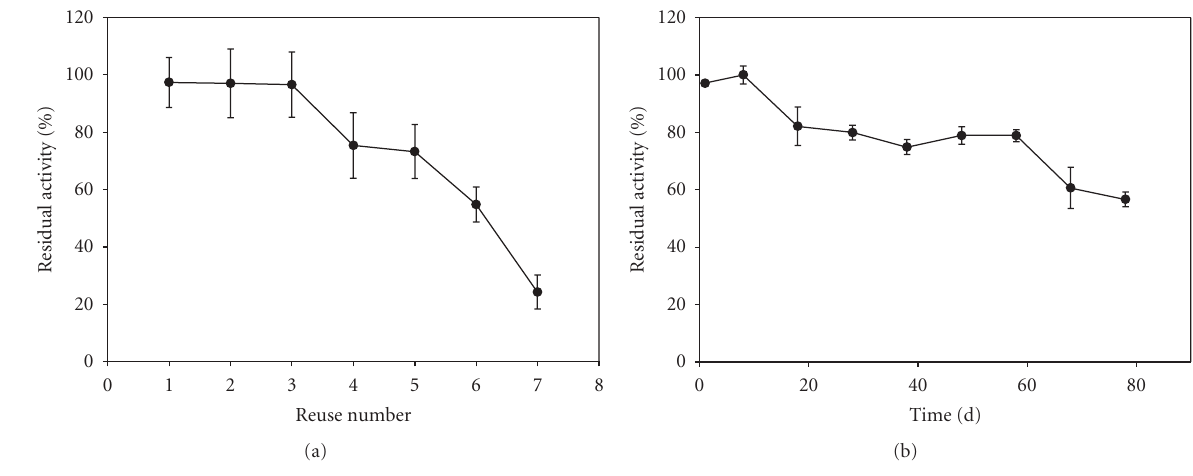
Figure 6: Reuse (a) and shelf life (b) of PVAG-PANIG-HRP.